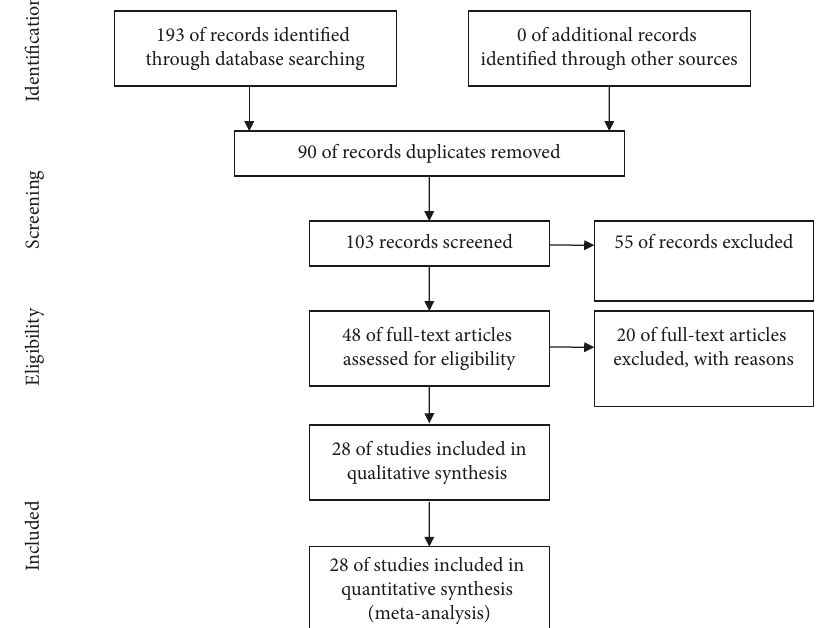
Figure 1: PRISMA flow diagram